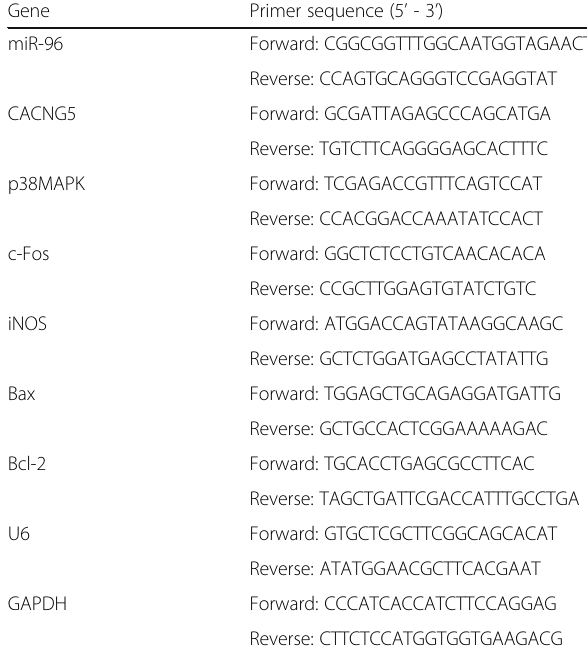
Table 1 Primer sequences of RT-qPCR Gene Primer sequence (5 ’ - 3 ’